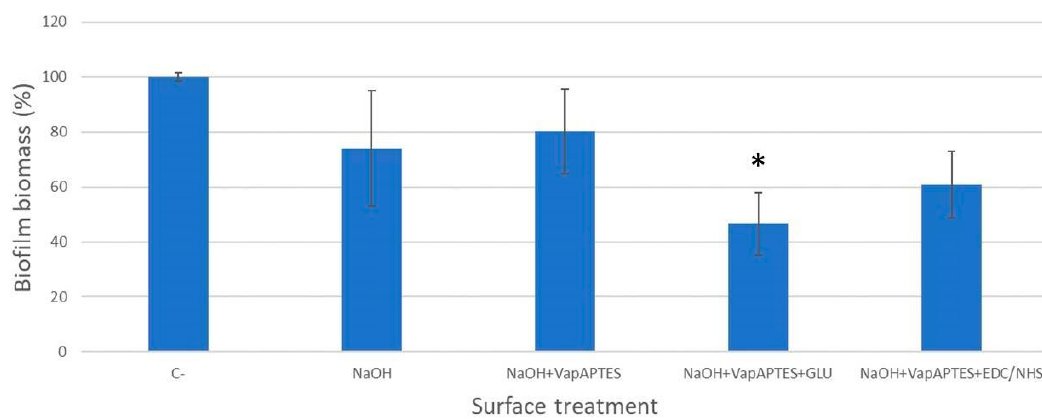
Figure 6. Biofilm biomass (%) of Staphylococcus aureus ATCC 6538 formed at 24 h of incubation on the surface of Ti-6Al-4V disks subjected to different surface treatments. Data are normalized to untreated controls (C − ). * p < 0.05.